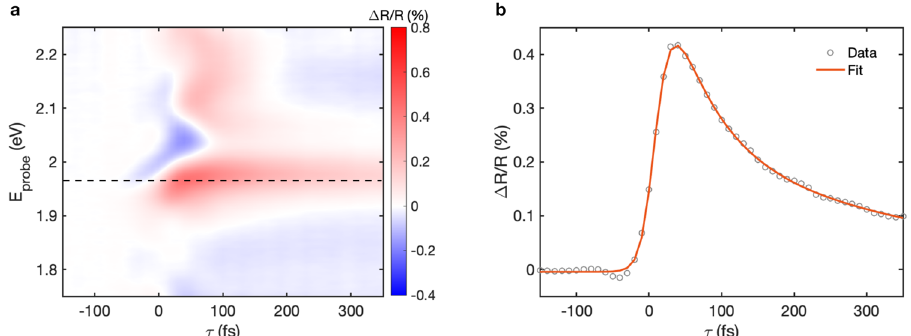
Fig. 4 Hot-carrier injection timescale. a Δ R / R map measured on the WS 2 /graphene HS following a sub-20 fs excitation at 1.2 eV and b extracted A exciton dynamics.